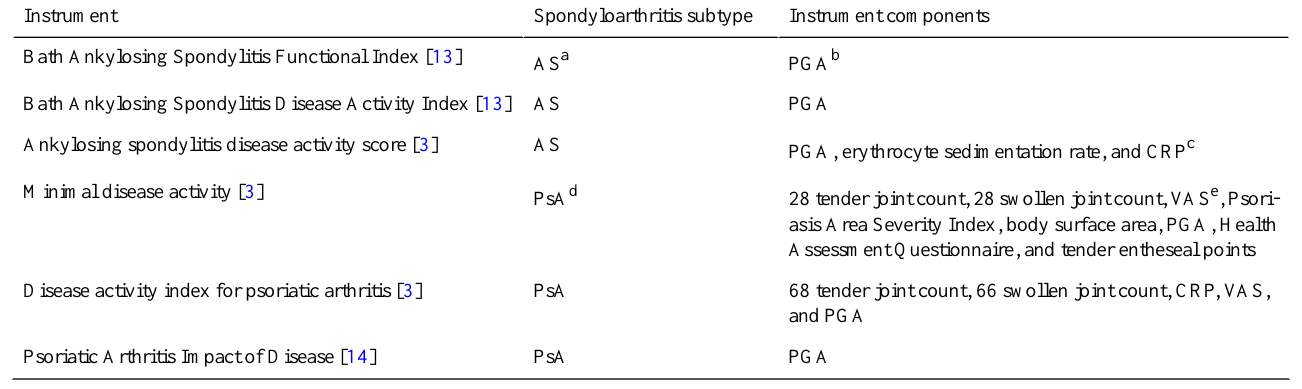
Table 1. Validated disease activity monitoring instruments for spondyloarthritis disease activity monitoring.